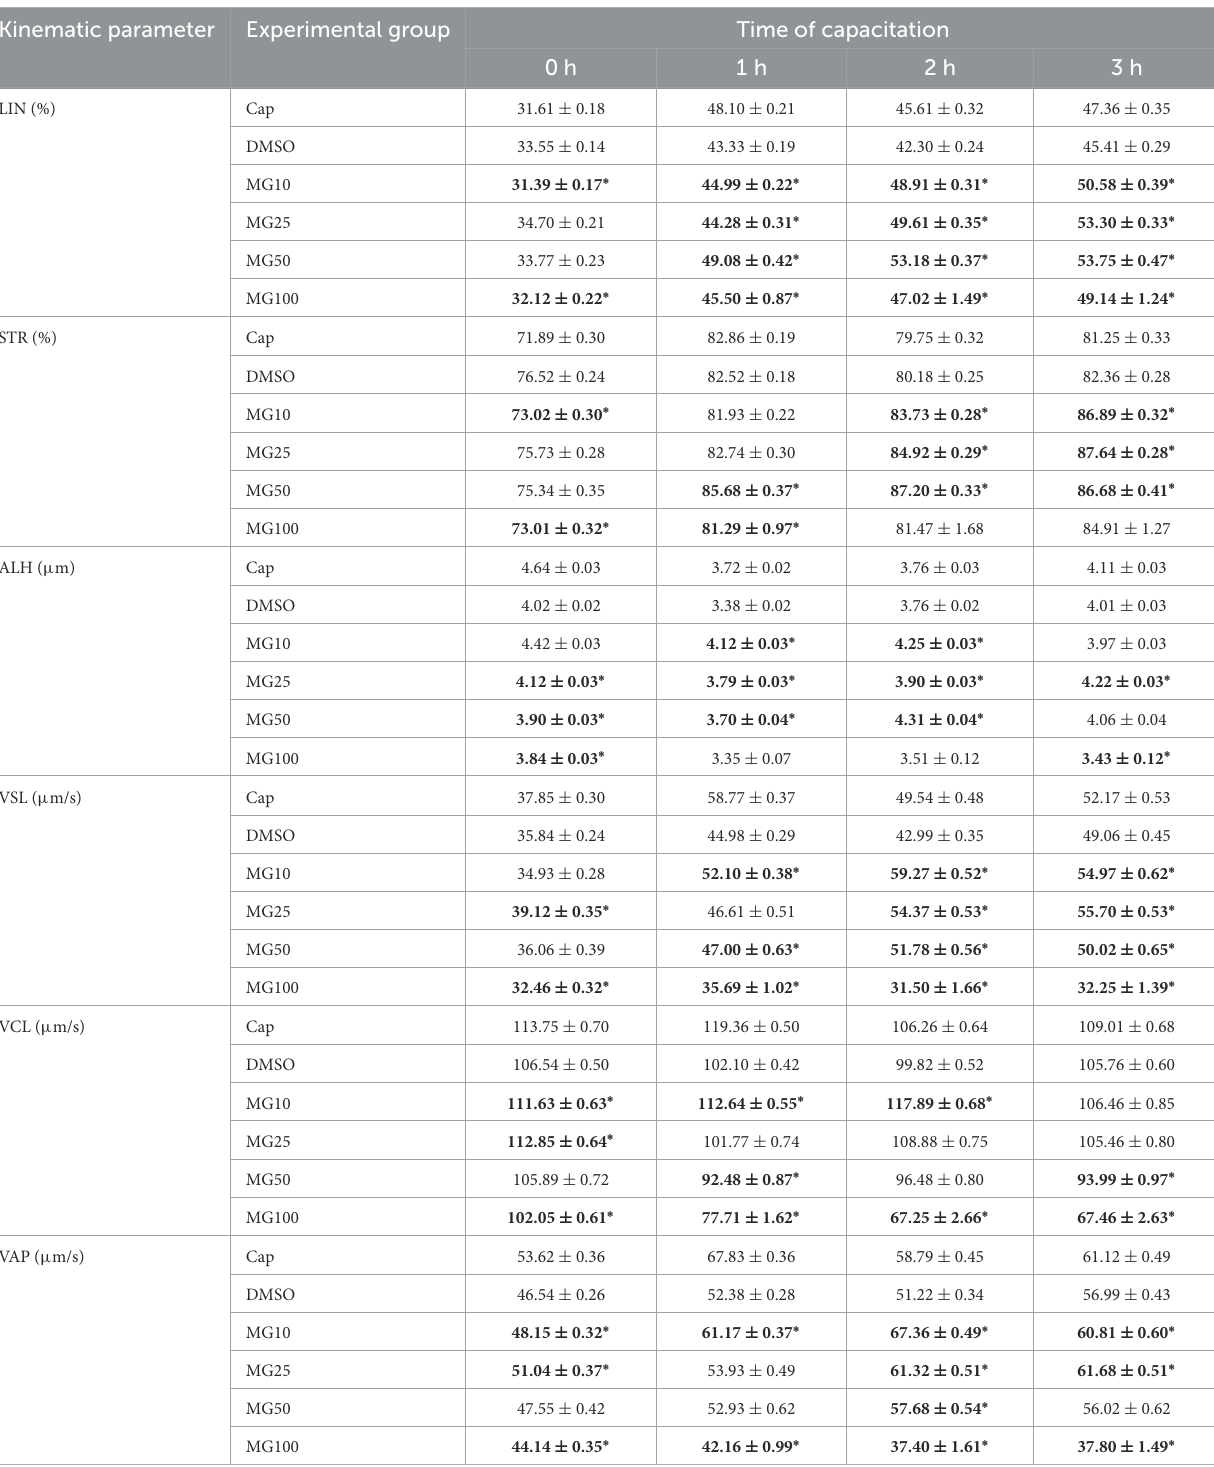
TABLE 2 Kinematic parameters evaluation during sperm in vitro capacitation (IVC) under proteasomal inhibition by MG-132 at various concentrations (10, 25, 50, and 100 µ M) including and vehicle control (DMSO) control. Kinematic